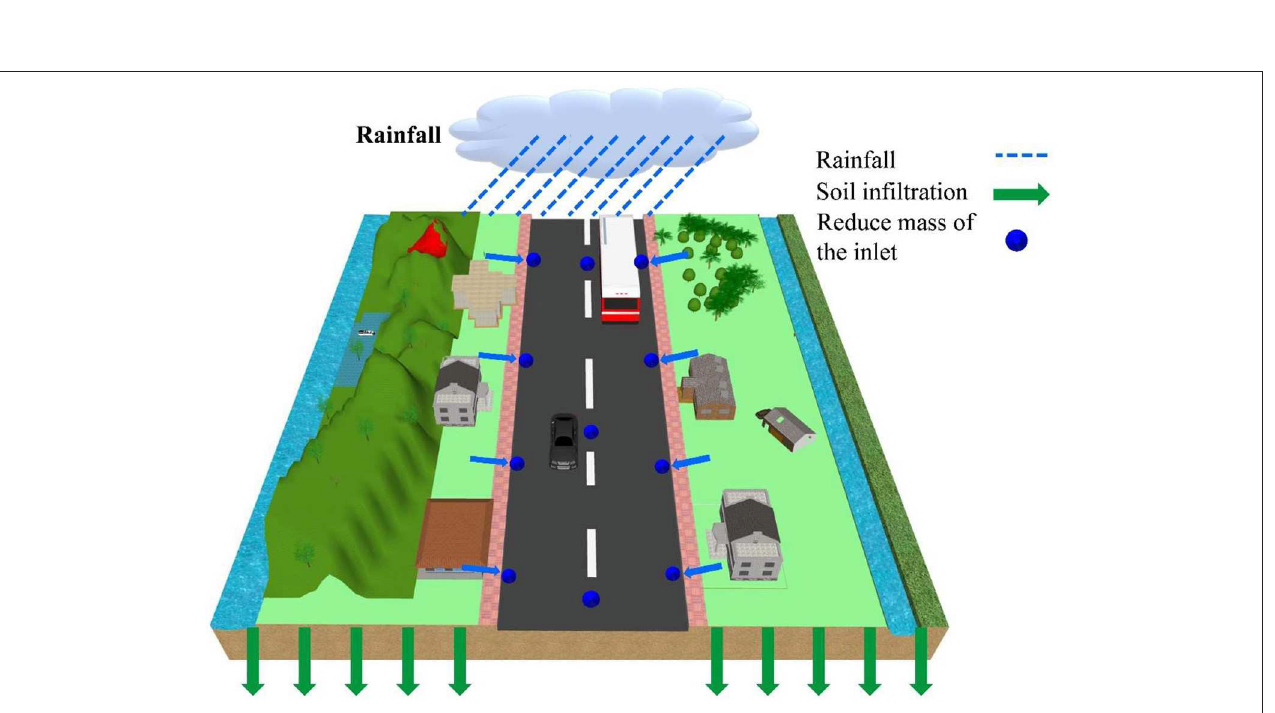
FIGURE 2 | Schematic diagram of the new